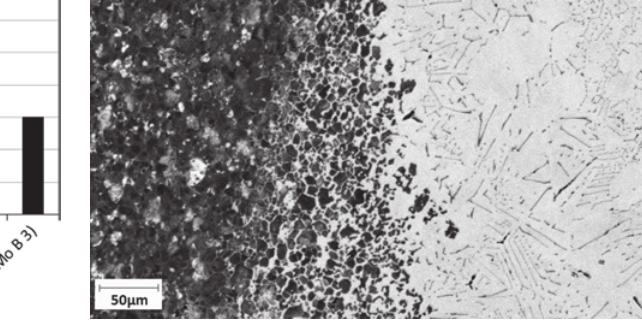
Fig. 6: Penetration depths of the melt into the substrate